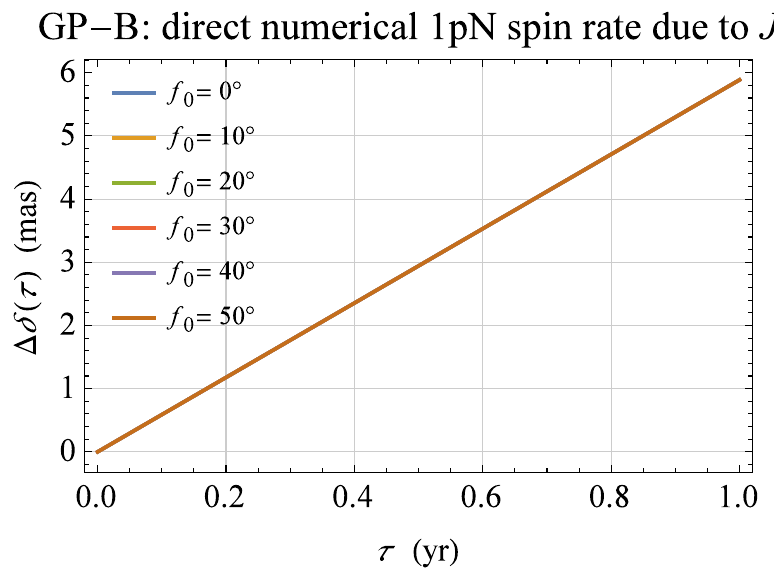
Figure 2. Numerically produced direct 1pN J 2 -induced yearly shifts ∆ δ ( τ ) , in mas, of the declination δ of the spin axis of a gyroscope orbiting the Earth along a fictitious Keplerian ellipse for some different initial values of the true anomaly f 0 . Each of the times series ∆ δ ( τ ) was obtained by simultaneously integrating Equation(1) with J 2 (cid:54) = 0 and Equation(4) with J 2 = 0, and subtracting from each of them the corresponding time series obtained by integrating both Equation(1) and Equation(4) with J 2 = 0 (the de Sitter trends). Then, arcsin S z ( τ ) was calculated for each of the resulting solutions S z ( τ ) . The initial conditions adopted, common to all of the runs, were those of GP-B [25], summarized in Table1. All the shifts are independent of f 0 , and agree with the result calculated analytically in Section3.1.2. The slope amounts to ∆ ˙ δ = 5.8masyr − 1